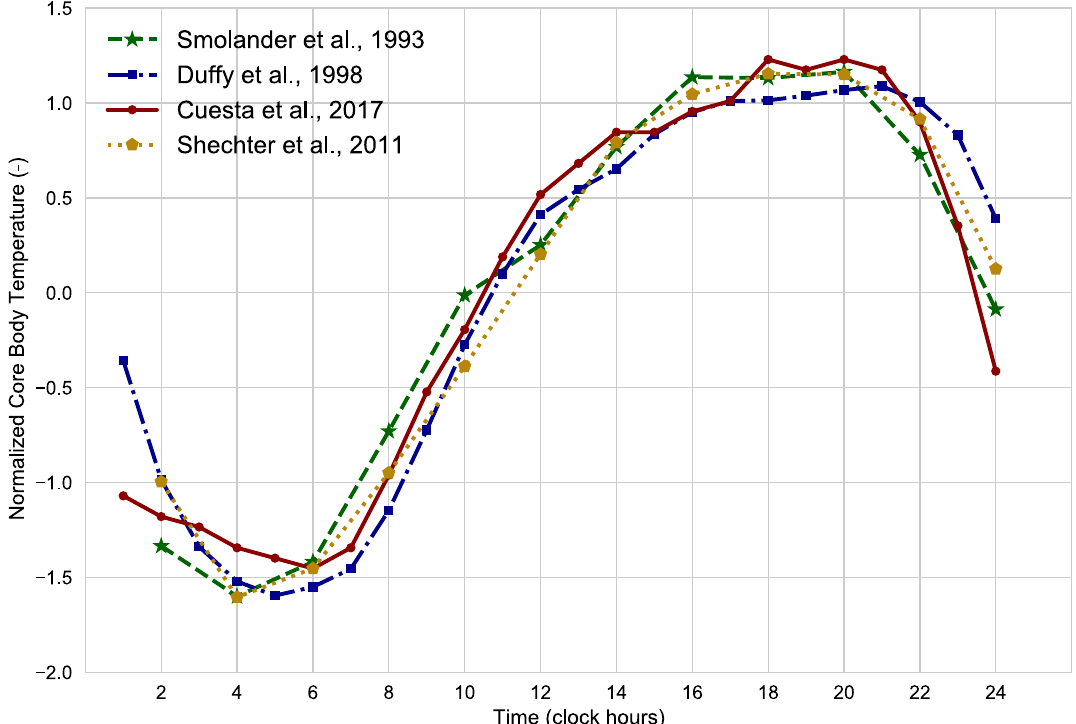
Figure 1. Normalized (Z-score) core body temperatures as a function of the time of day measured in controlled but not constant routine (i.e. sleep is allowed) experimental conditions. Data from Smolander et al. 30 , Duffy et al. 35 , Cuesta et al. 29 , and Shechter et al. 27